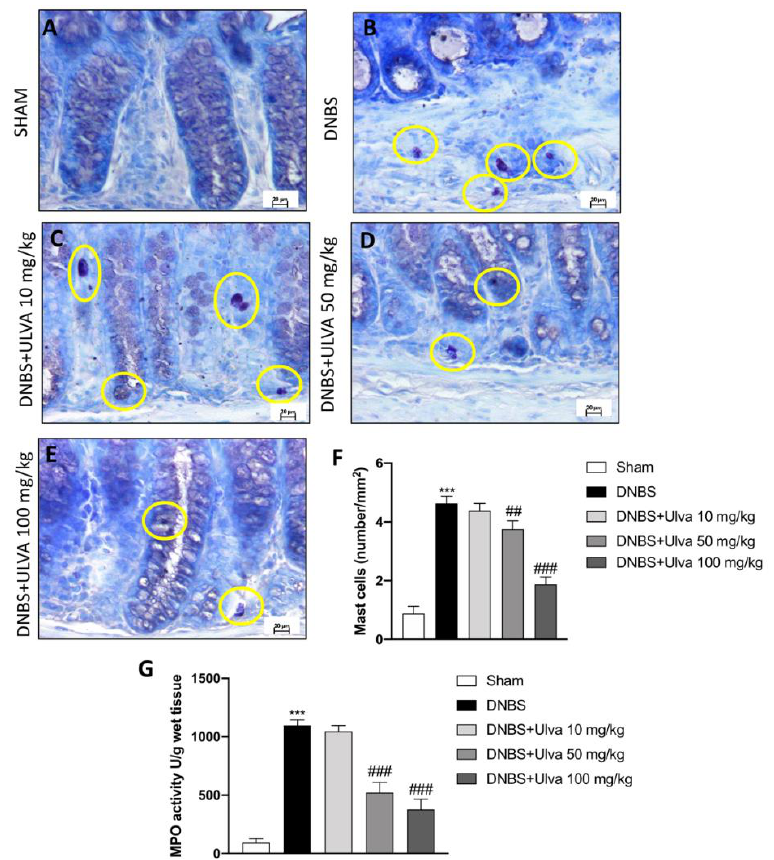
Figure 2. Effect of Ulva pertusa on mast cells in colon tissues after DNBS-induced colitis. A high number of mast cell ( B , F ) and neutrophil infiltration ( G ) was found in mice with DNBS-induced colitis, compared to control animals ( A , F , G ). Ulva pertusa 10 mg/kg was ineffective in reducing mast cell count and MPO activity ( C , F , G ). While a decreased number of mast cells and MPO activity was identified in mice treated with Ulva at doses of 50 mg/kg ( D , F , G ) and 100 mg/kg ( E – G ). Mast cells were highlighted by the yellow circles. Data are representative of at least three independent exper- iments. Values are means ± SD. One-way ANOVA test followed by Bonferroni. *** p < 0.001 vs. Sham; ## p < 0.01 vs. DNBS; ### p < 0.001 vs. DNBS.